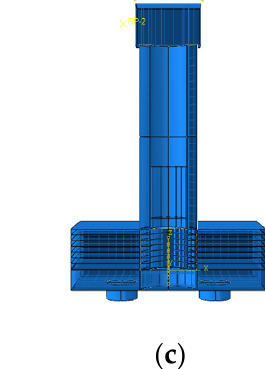
Figure 14. Diagrams of different structural models. ( a ) Shear key only; ( b ) bottom plate; ( c ) bottom plate + shear key.